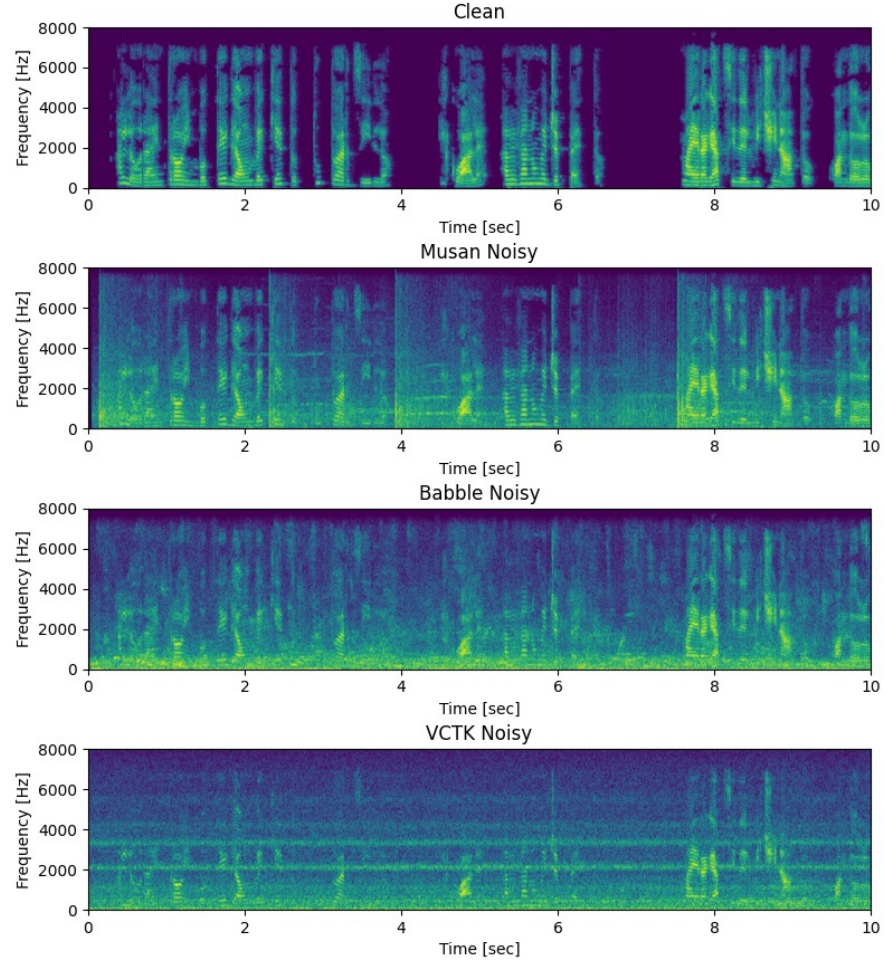
Figure 7. Noisy speech in three